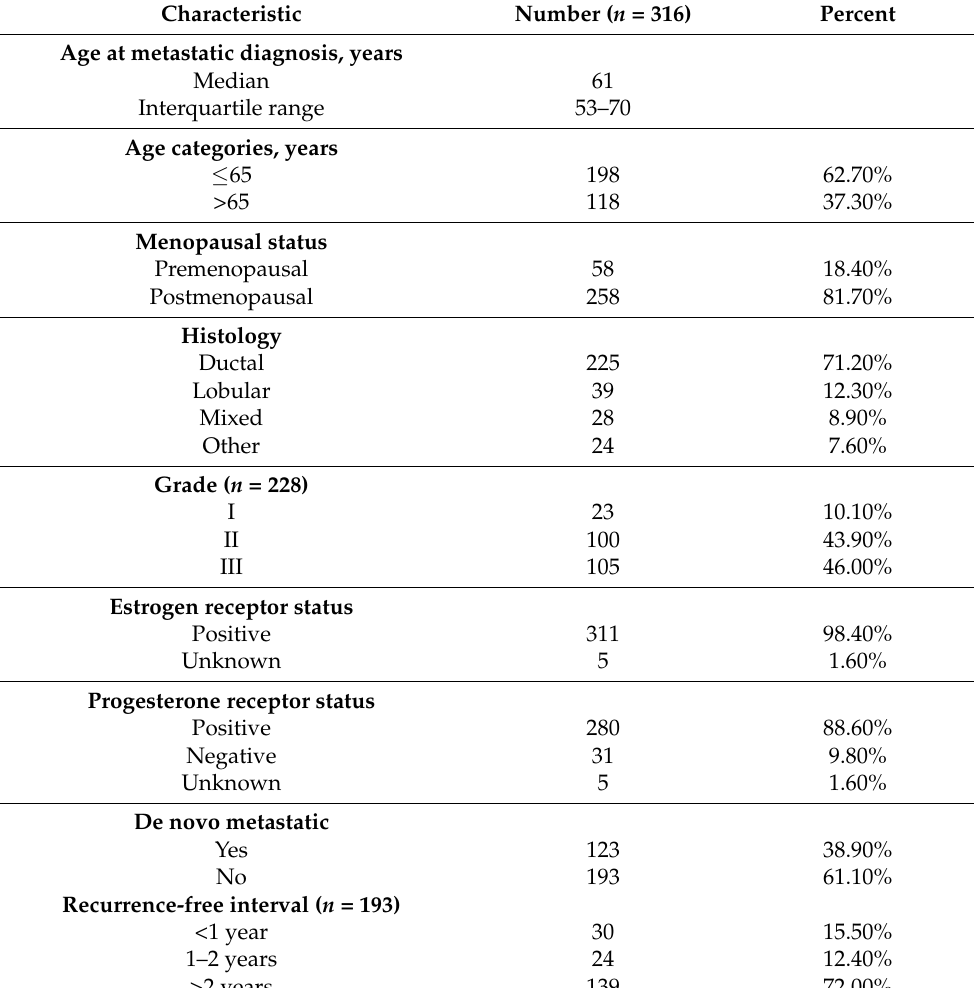
Table 1. Baseline characteristics of